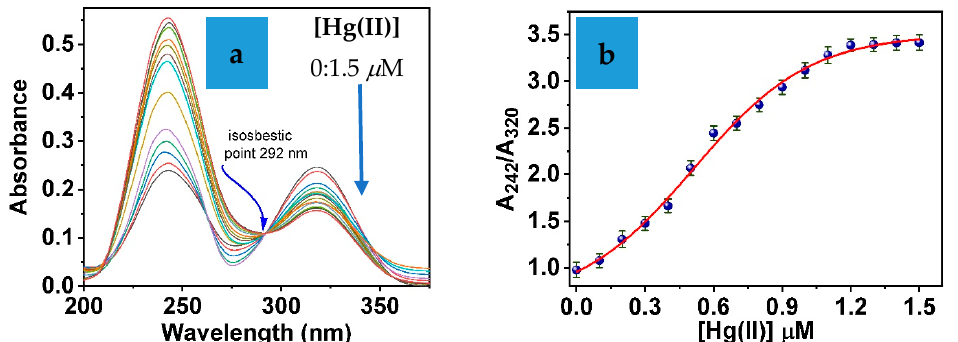
Figure 4. ( a ) Behavior of UV–Vis spectrum of IXZD in the presence of 0:1.5 μ M Hg(II) and ( b ) A 242 /A 320 absorbance ratio of IXZD against [Hg(II)].